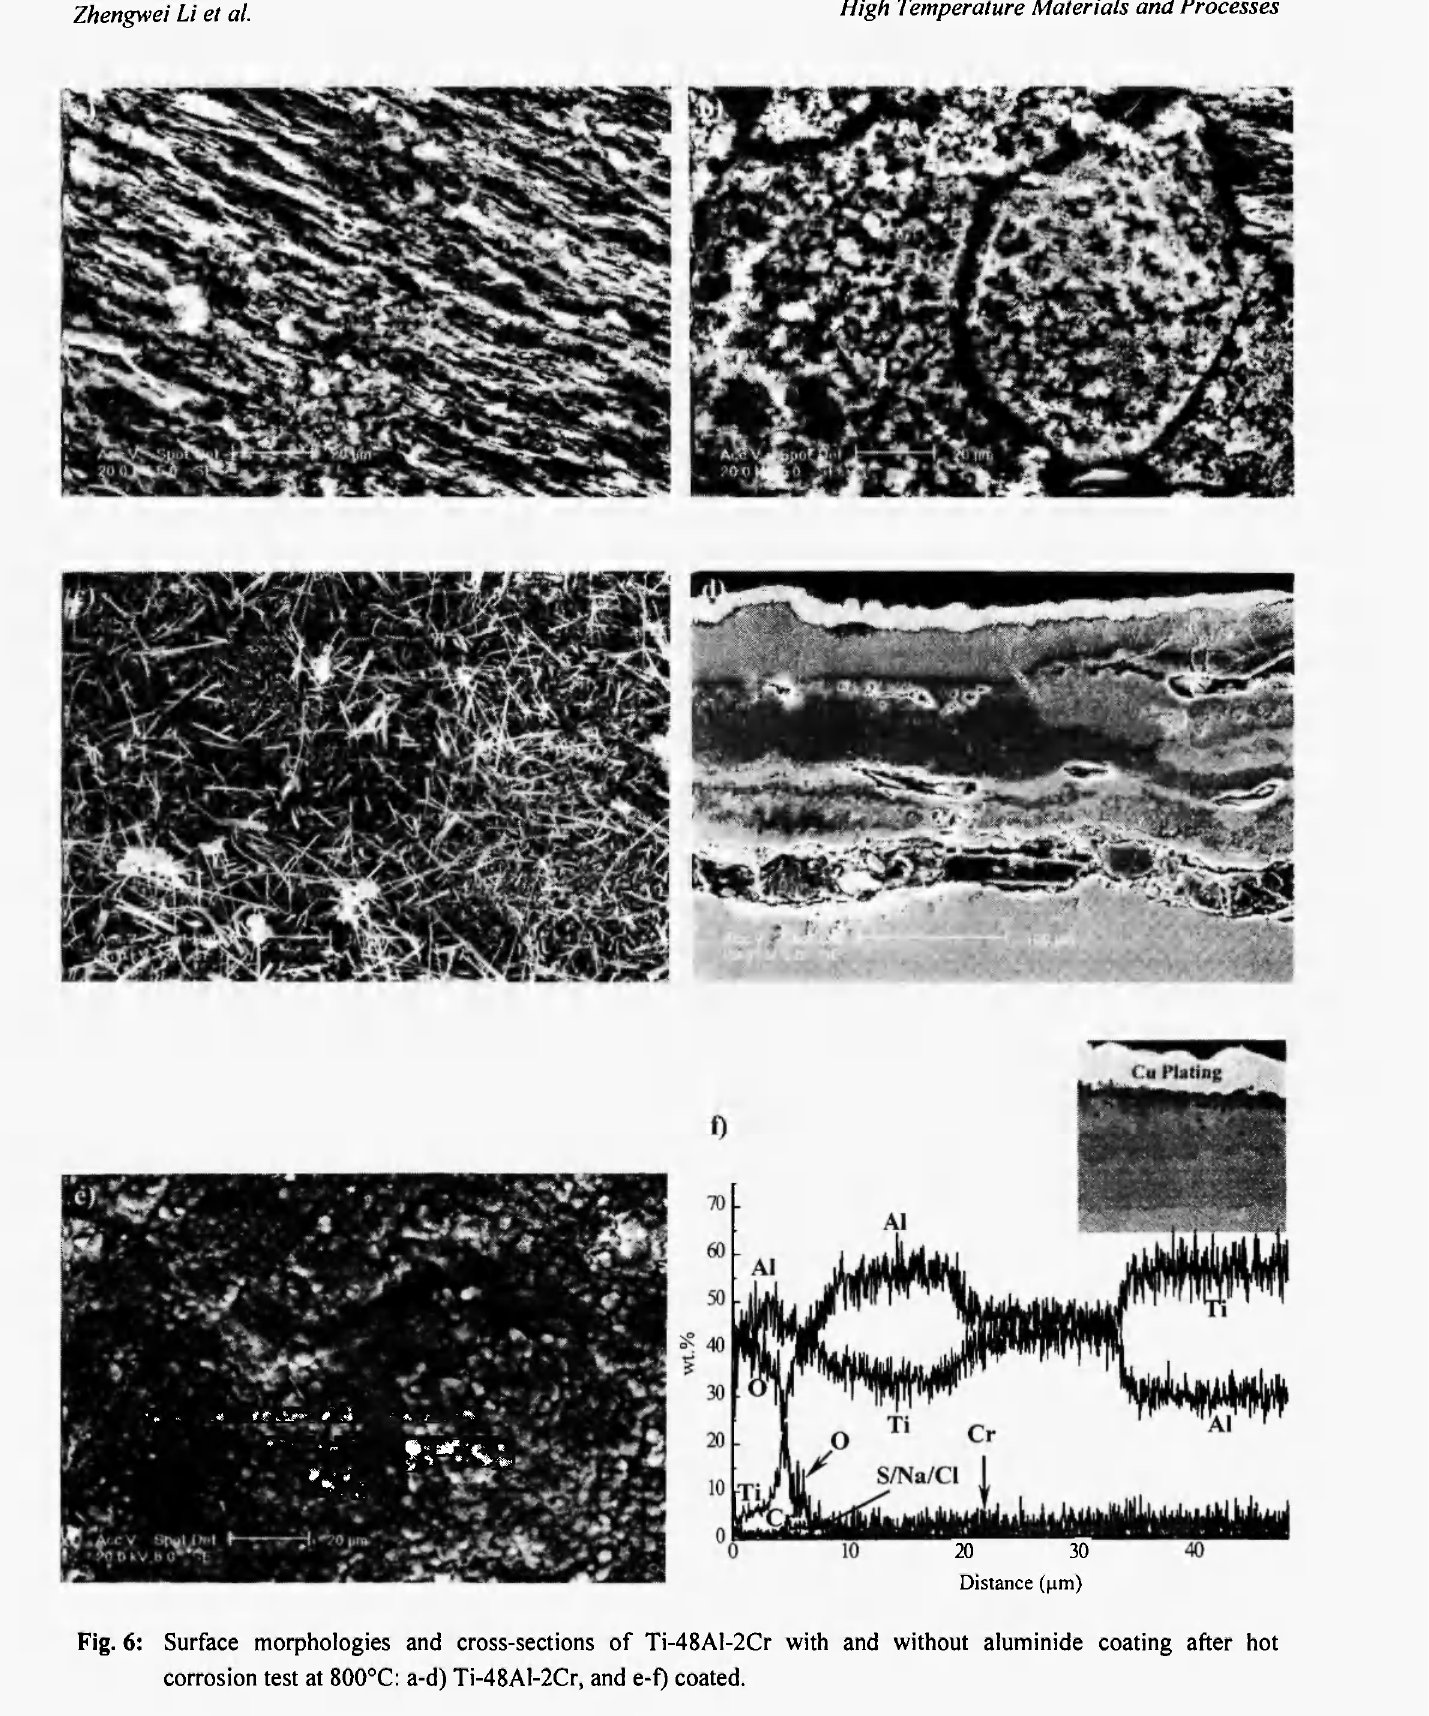
Fig. 6: Surface morphologies and cross-sections of Ti-48Al-2Cr with and without aluminide coating after hot corrosion test at 800°C: a-d) Ti-48Al-2Cr, and e-f)